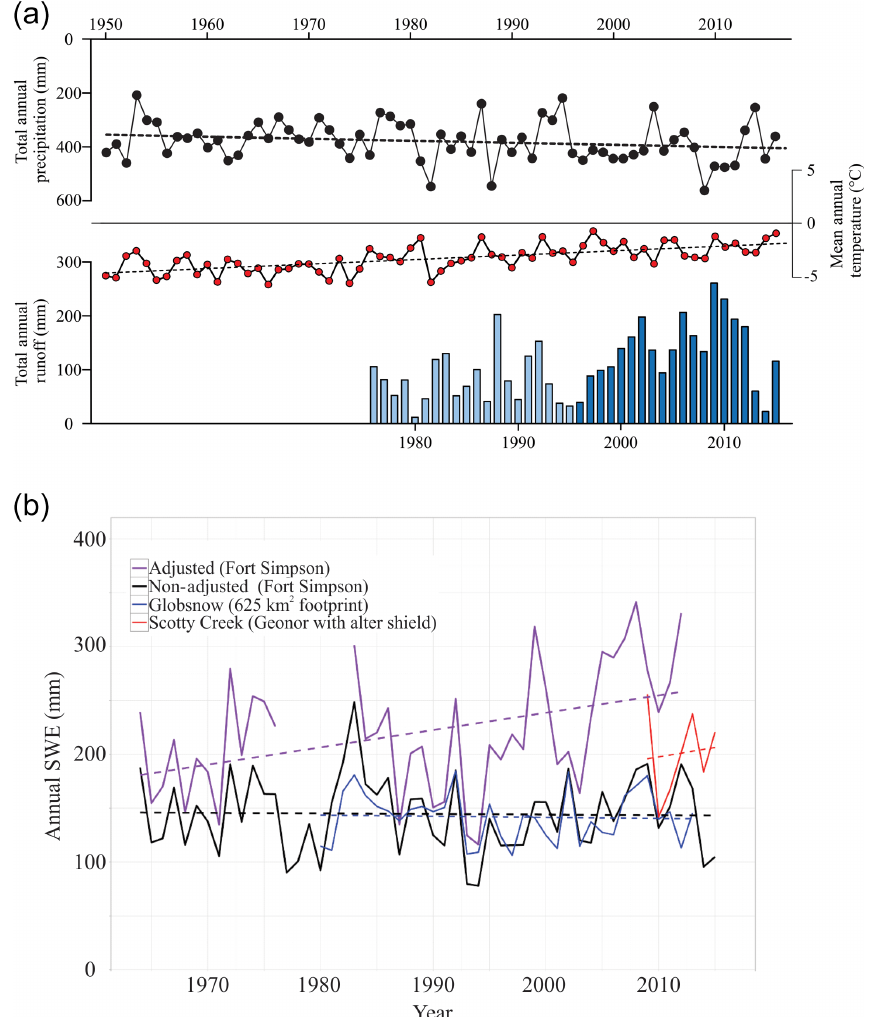
Figure 9. Historical precipitation, temperature, and runoff at Scotty Creek (a) . Runoff after 1995 was measured directly by the Water Survey of Canada, and runoff prior to 1995 was estimated by interpolation from Water Survey of Canada data at an adjacent watershed (Jean Marie River). Precipitation and air temperature were measured at the Fort Simpson A climate station by Environment and Climate Change Canada. Adjusted and unadjusted total annual snow water equivalent (SWE) at Fort Simpson Airport (b) . Also shown is the SWE measured at Scotty Creek (Geonor gauge with Alter shield) and SWE provided by the Globsnow data set for the same